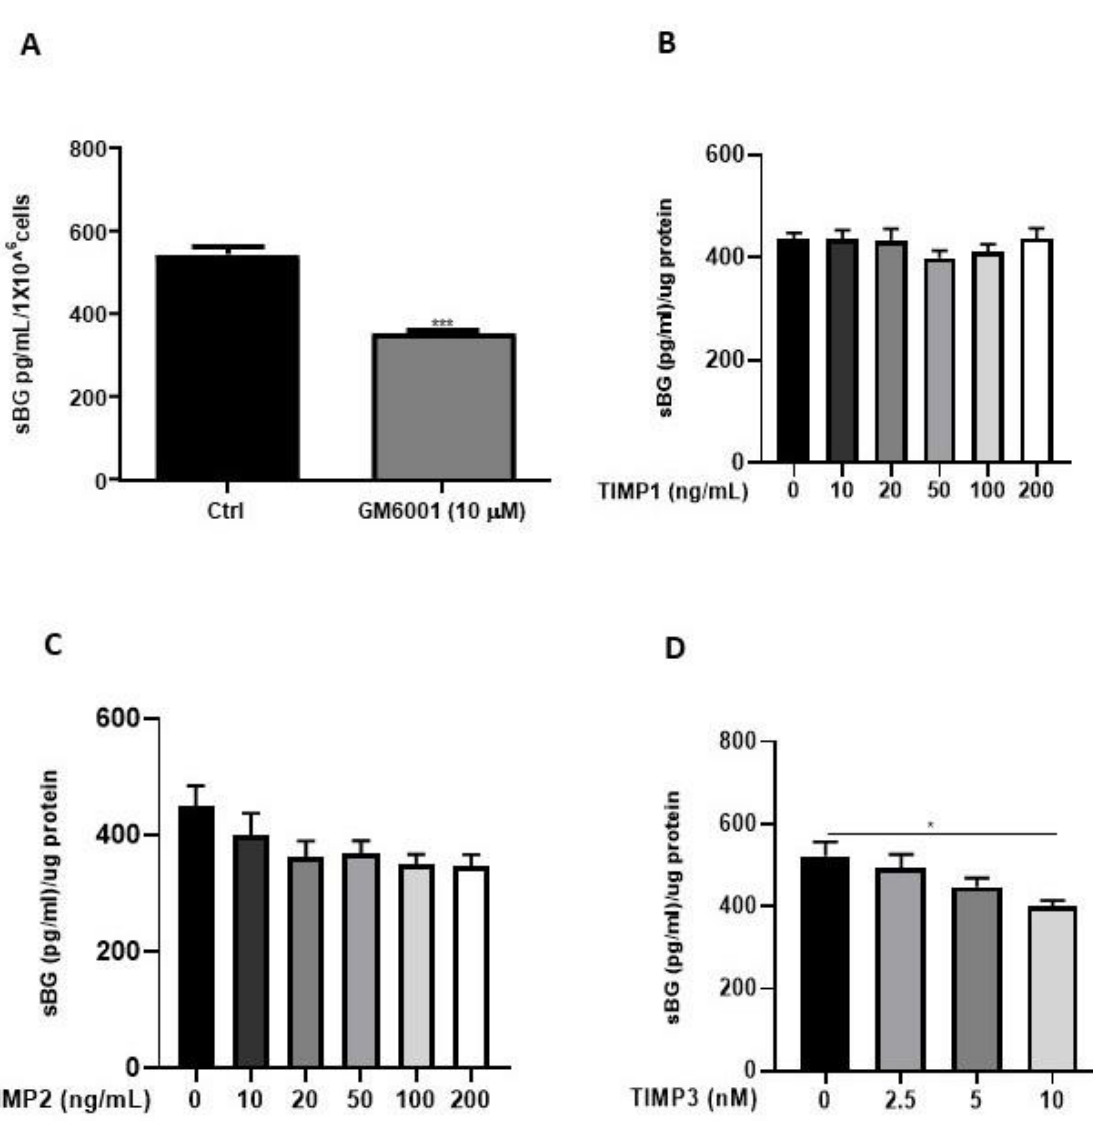
Figure 5. BG shedding is modulated by MMPs. Epithelial 12Z cells were treated with the broad-spectrum MMP inhibitor, GM6001 (10 µM) ( A ), or increasing concentrations of TIMP1 and TIMP2 (both with 10 – 200 ng/mL) ( B,C ) or TIMP3 (2.5 – 10 nM) ( D ) for 48 h, and supernatants were analyzed using sBG ELISA. Both GM6001 and TIMP3 treatment significantly attenuated BG shedding in 12Z cells whereas TIMP1/2 showed no significant effects. Each bar represents the mean ± SEM of three independent experiments performed in duplicate. * p ≤ 0.05, *** p < 0.001. sBG, soluble